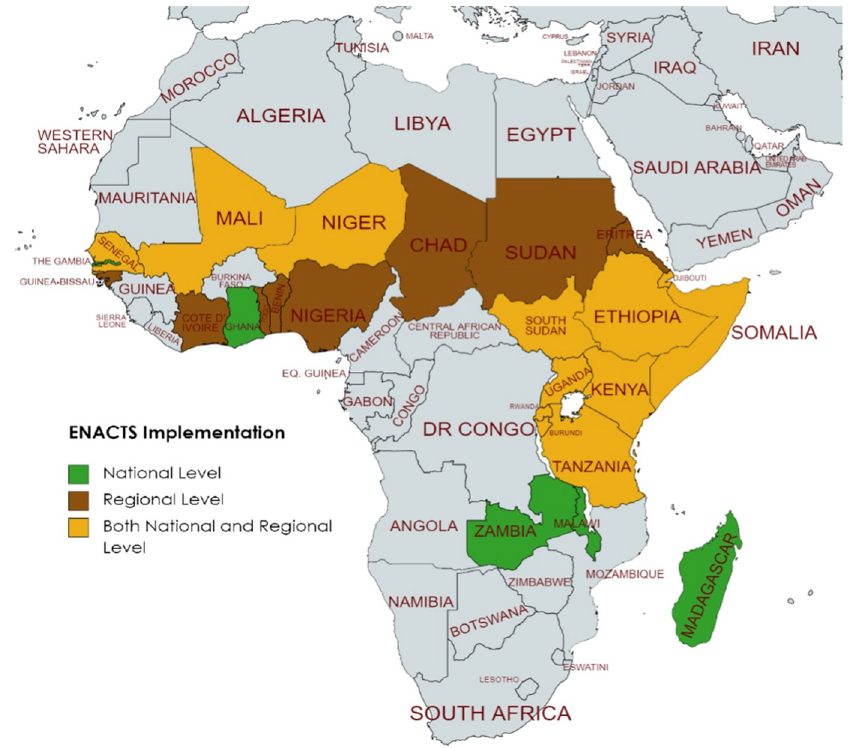
Figure 3. Countries and regions where ENACTS has been implemented or is in the process of being implemented. The brown color shows where ENACTS has been implemented at the regional level, while the green color shows where ENACTS has been implemented only at the national level. Countries in orange are those in which ENACTS has been implemented both at the regional and the national levels.